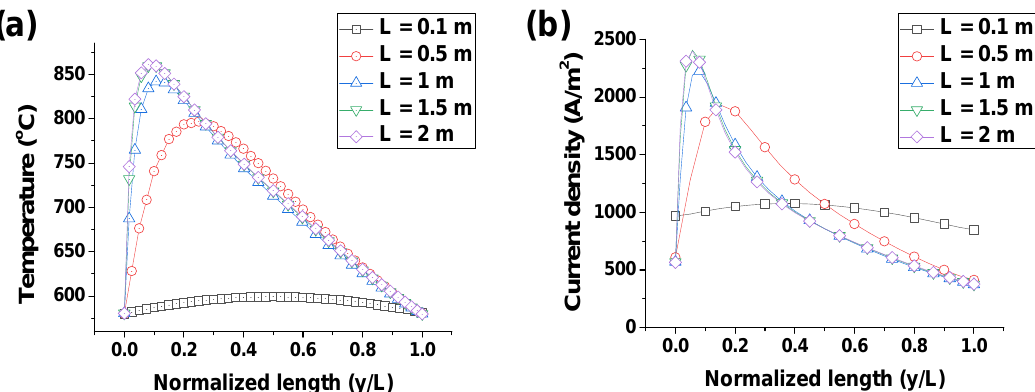
Figure 8. ( a ) Normalized temperature and ( b ) current density distribution relative to the length for the Figure 8. (a)Normalized temperature and (b)current density distribution relative to the length for the counter-flow counter ‐ flow type. counter ‐ flow type.